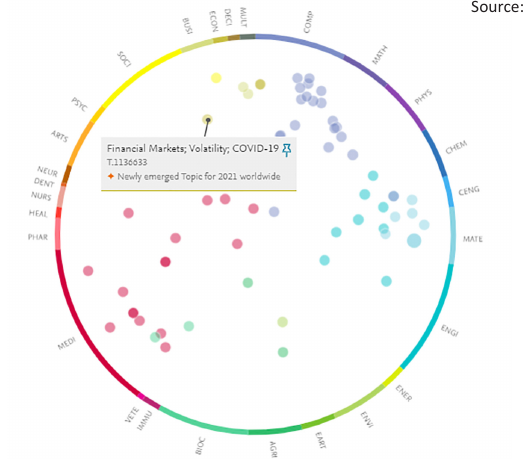
Figure 3. Newly emerged topics for SDG 7 in